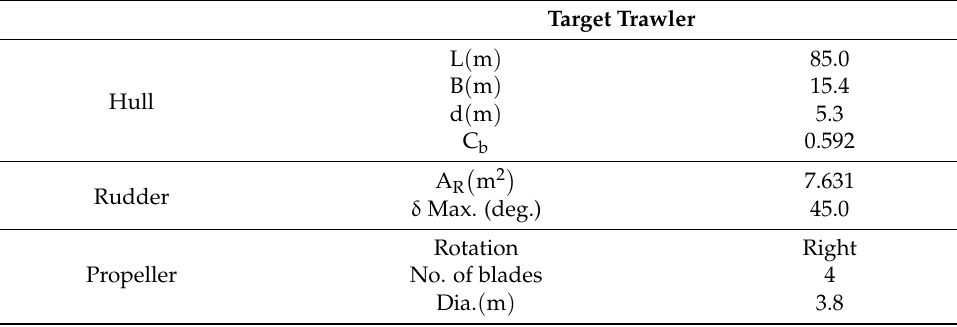
Table 4. The main specifications of the target